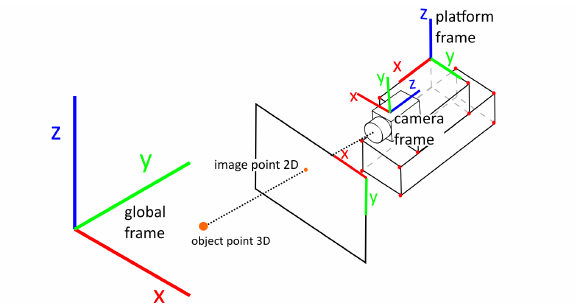
Figure 2. Relationship between the position of the GNSS Figure 3. Relationship between an object point in the global antenna in the platform frame and its position observed in the frame and its position observed in the image. global frame.